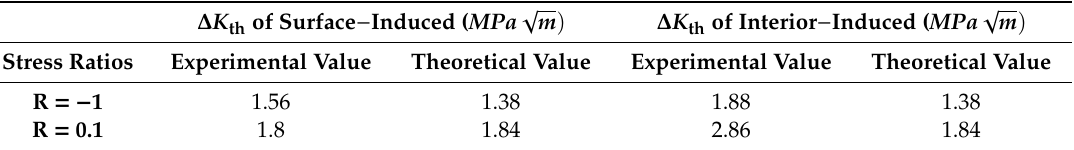
Table 3. Experimental and theoretical e ff ective